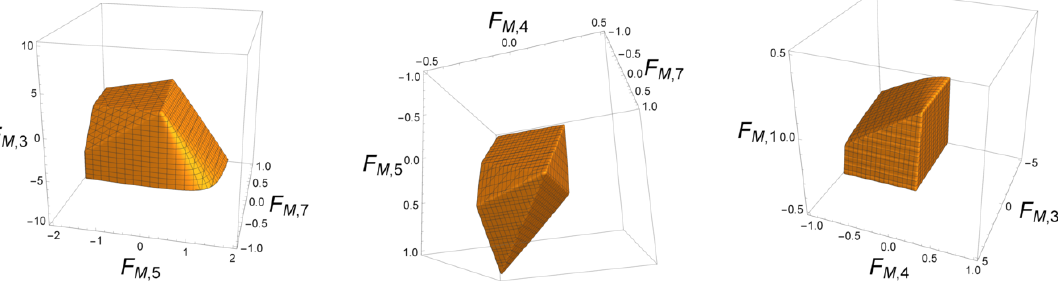
Figure 25 . Representative cases for three M -type operators. Allowed parameter spaces are de- scribed by combining a pyramid and a